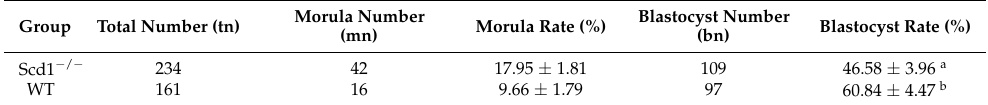
Table 2. The effect of Scd1 knockout on blastocyst development rate. Group Total Number (tn) Morula Number (mn) Morula Rate (%) Blastocyst Number